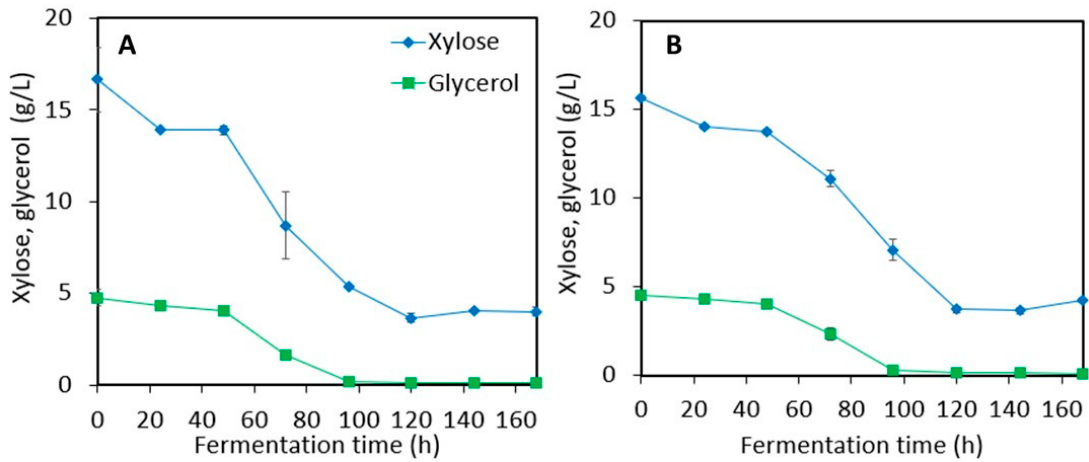
Figure 9. Xylose ( (cid:7) ) and glycerol ( (cid:4) ) consumption by P . rhodozyma in ( A ) 60% concentrated stillage Figure 9. Xylose ( ♦ ) and glycerol ( ■ ) consumption by P . rhodozyma in ( A ) 60% concentrated stillage media with 6.0 g / L yeast extract and ( B ) 60% concentrated stillage media with 1.0 g / L ammonium sulfate. media with 6.0 g/L yeast extract and ( B ) 60% concentrated stillage media with 1.0 g/L ammonium sulfate.